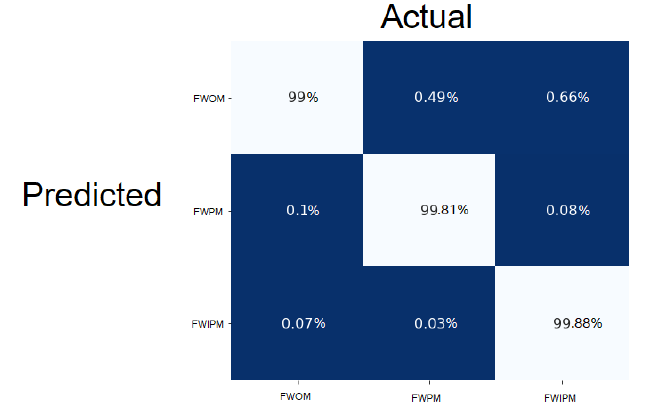
Figure 15. The confusion matrixes of two models: ( a , b ) show the confusion matrix for the identifica- tion and classification of face mask in three classes FWOM (Face Without Mask), FWPM (Face with Proper Mask), and FWIPM (Face With Improper Mask) by using Inception V3, and MobileNetV2 models respectively.